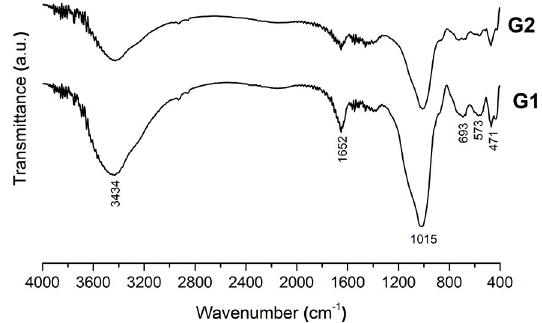
Figure 6. FTIR spectra of G1 and